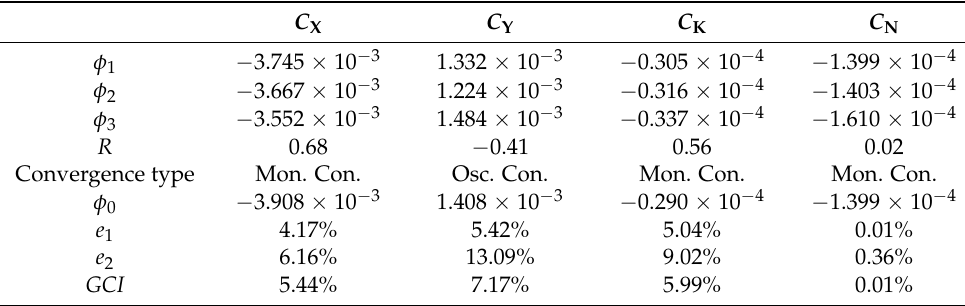
Table 4. Mesh convergence